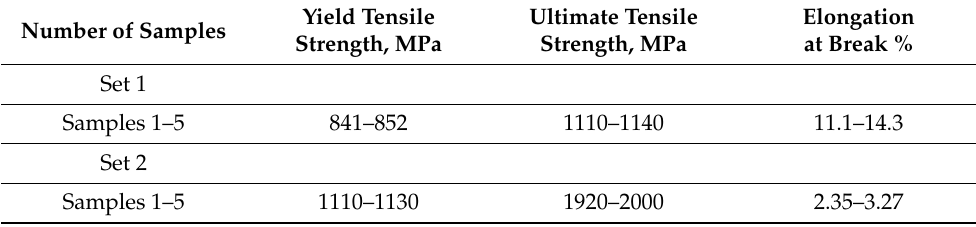
Table 5. Summarized mechanical properties from tensile tests.